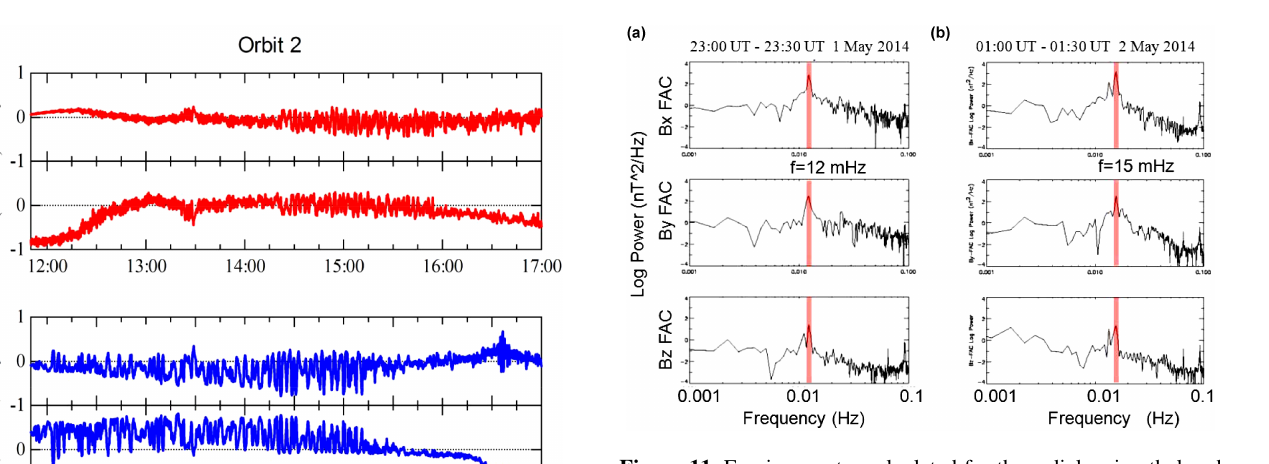
Figure 11. Fourier spectra calculated for the radial, azimuthal and compressional components of the Van Allen Probe A magnetic field in 5min sliding averaged mean field-aligned coordinates during Or- bit 3 from 23:00 to 23:30UT on 1 May 2014 (a) and from 01:00 to 01:30UT on 2 May 2014 (b) . Vertical lines indicate the frequencies of dominant spectral peaks at 12 and 15mHz.